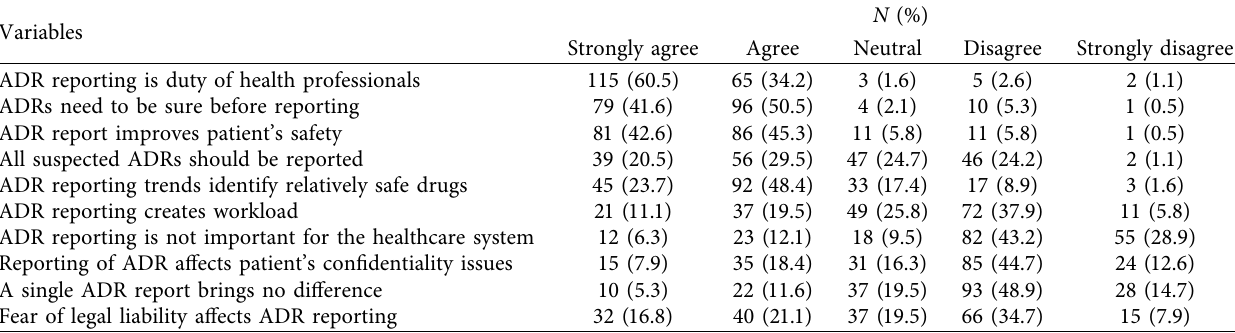
Table 5: Attitude of healthcare providers towards ADR reporting in Mizan Tepi University Teaching Hospital from August to September